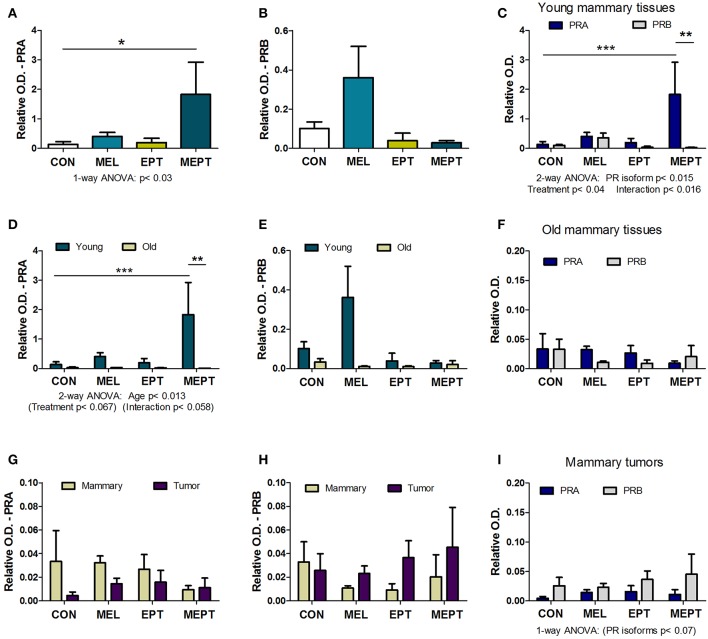
The combined melatonin-estradiol-progesterone therapy alters the balance of the progesterone receptor isoform protein expression in young mammary tissue, but not old mammary glands and tumors. PRA and PRB protein expression was determined by western blot analysis and normalized to β-actin. (A) PRA expression in the young mammary glands (3-month-old in estrus) was significantly elevated in MEPT treated mice compared to the CON group (*p < 0.05, Dunnett's multiple comparison post-test; p < 0.03, one-way ANOVA). (B) The PRB isoform in the treatment groups was not significantly different than CON mice by one-way ANOVA. (C) Comparison of expression levels of PRA and PRB in the young mammary glands shown individually in (A,B) by two-way ANOVA analysis demonstrated significance for the treatments (p < 0.04), type of PR isoform (p < 0.015), and their interaction (p < 0.016). Additionally, PRA expression in young MEPT-treated glands was significantly higher than PRA in CON mice (***p < 0.001 Bonferroni post-test; n = 4–9) and than PRB in MEPT mice (**p < 0.01 Bonferroni post-test). (D) Compared to the 3-month-old mammary tissues (Young), lower expression of PRA isoforms was detected in mammary tissues from mice with mean ages ranging between 12.9 and 14.2 months (Old) in various stages of the estrous cycle by two-way ANOVA (age p < 0.013), with PRA in young MEPT mice significantly different than young CON mice (***p < 0.001, Bonferroni post-test) and than old MEPT mice (**p < 0.01, Bonferroni post-test). (E) In contrast, comparisons of PRB expression in young and old mammary tissues was not significant by two-way ANOVA. (F) Unlike in the young mammary tissues, comparison for both PR isoforms in the old mammary tissues did not result in any significant differences by two-way ANOVA (n = 4). (Note the lower range for the y-axis for panel F vs. C). Compared to old mammary tissues, the mammary tumors excised from mice in various stages of the cycle with mean ages ranging between 8.9 and 13.7 months were not significantly different for (G) PRA and (H) PRB by two-way ANOVA. Note the reduced range for the y-axis compared to (A,B,D,E). (I) The comparison between the two isoforms also showed no significant differences in mammary tumors, although by two-way ANOVA, the type of PR isoform approached significance p < 0.07, with no significance for treatment or their interaction (n = 3–5). Mean ± SEM are shown.